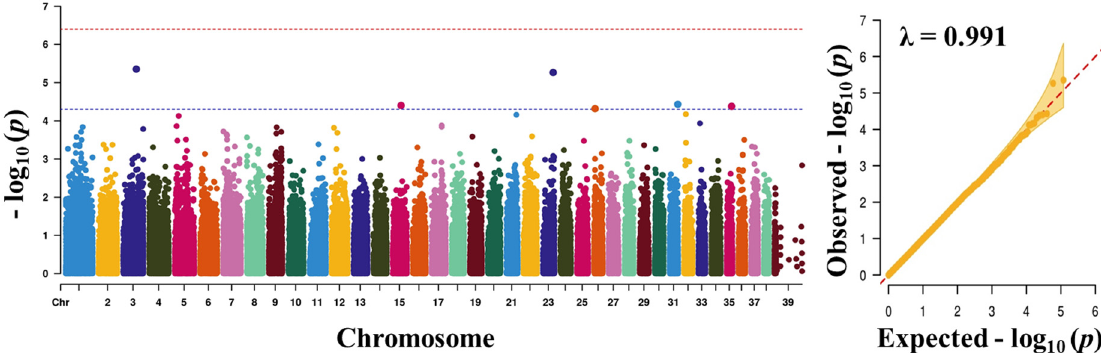
Figure 4. Manhattan plots of mapped single nucleotide polymorphism (SNP) markers associating with length. Red line designates the Bonferroni-corrected significance threshold level of p < 4 × 10 − 7 and blue line shows genome wide significant threshold level of p < 5 × 10 − 5 . The quantile-quantile (Q-Q) plot of the GWAS is shown in the right side. GWAS, genome-wide association study.